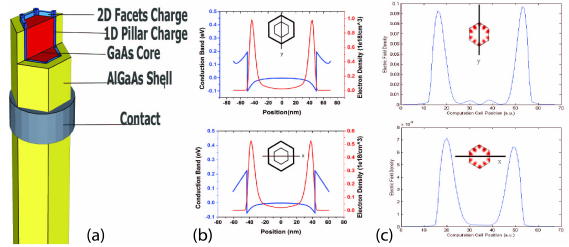
Figure 8: (a) The GaAs/AlGaAs core–shell nanowire schematic with electron charge positions. (b) The calculated conduction band en- ergy diagram and the electron density at y cross section (top) and x cross section (bottom) with high doping density. (c) FDTD-simulated (optical) electric field intensity of a hexagonal nanowire at y cross section (top) and x cross section (bottom). The insets are mode patterns ( TM 5 n ) in the transverse plane. The black boundaries rep- resent the interface between semiconductor and air.